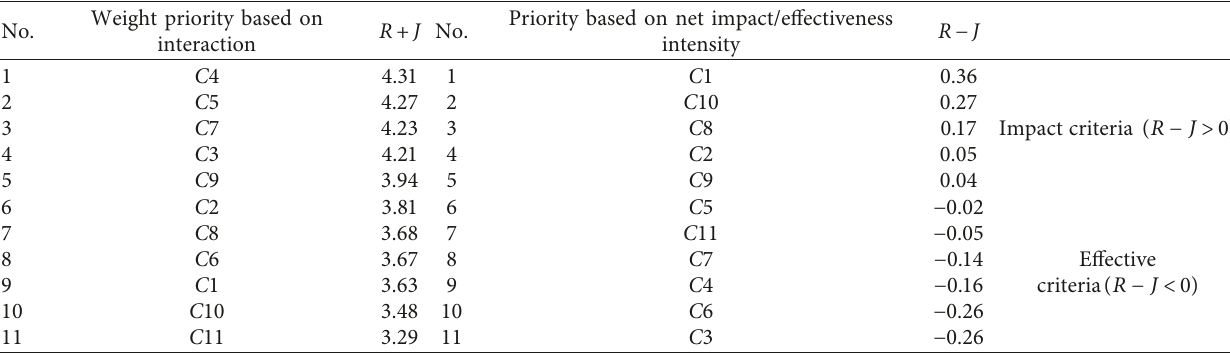
Table 8: The order of the final impact of subcriteria on other subcriteria and their final importance in the system. Weight priority based No.